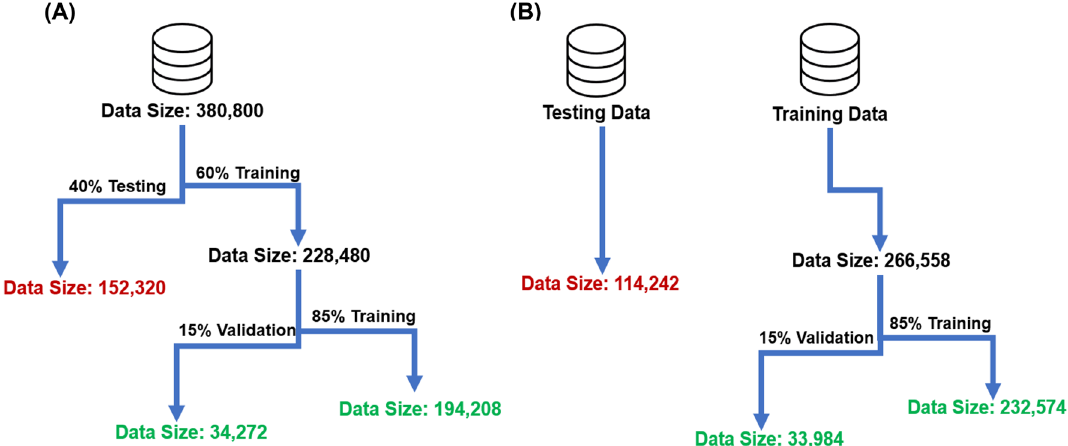
Figure 5. Illustrates the flow chart of ( A ) Model 1 and ( B ) Model 2. ( A ) In model 1, all data from every experiment were concatenated and then randomly separated into two different data sets of (1) training and (2) testing by considering a ratio of 60% to 40%, respectively. The training set was further split into 85% training and 15% validation sets. ( B ) In model 2, one experiment was randomly chosen for testing, while the rest of the data was used for training and validation with a ratio of 85% to 15%, respectively.